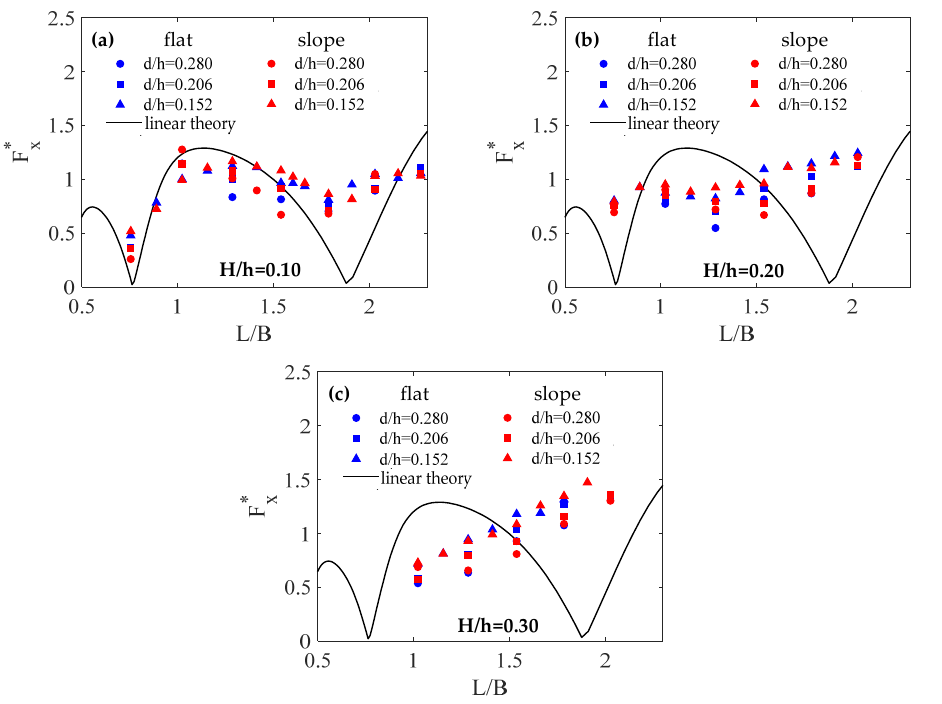
Figure 7. The horizontal wave forces due to regular waves in terms of the different relative wave heights ( a ) H/h = 0.10, ( b ) H/h = 0.20 and ( c ) H/h = 0.30. The theoretical results from linear theory for flat bottoms are compared with the experimental data for both flat bottoms and slopes in the figure, as well as in Figures 8 and 9.